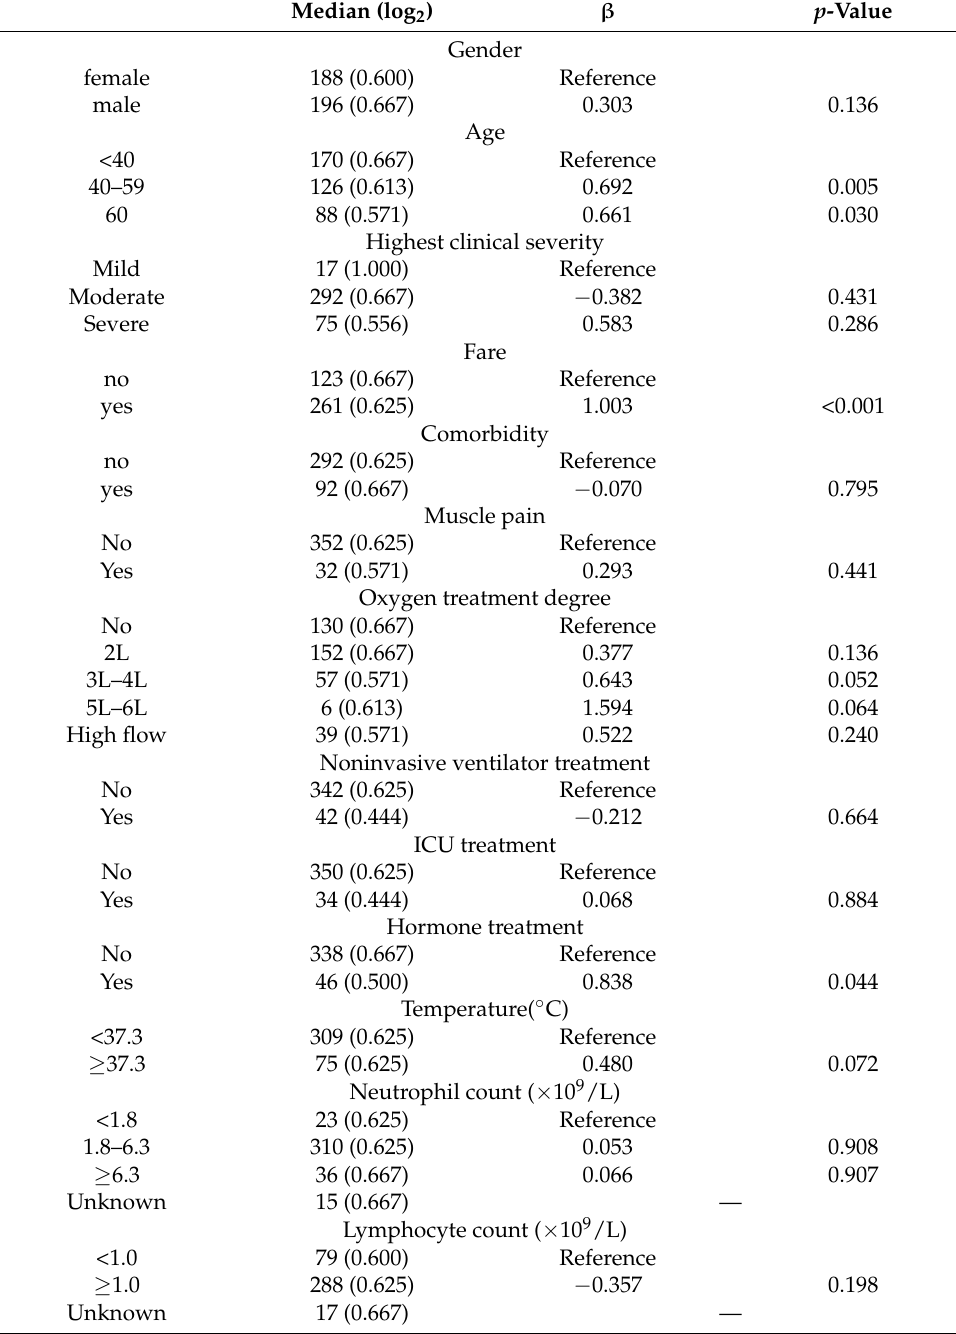
Table 3. Multivariate linear regression analysis of factors related to the rate of decline in the NAb titers of